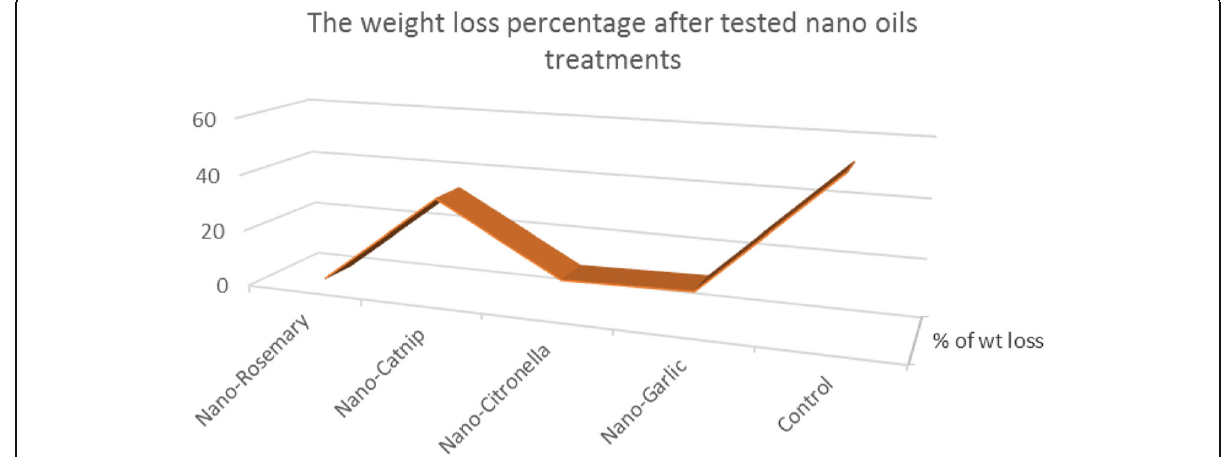
Fig. 2 Effect of tested nano-oils on broad beans weight loss